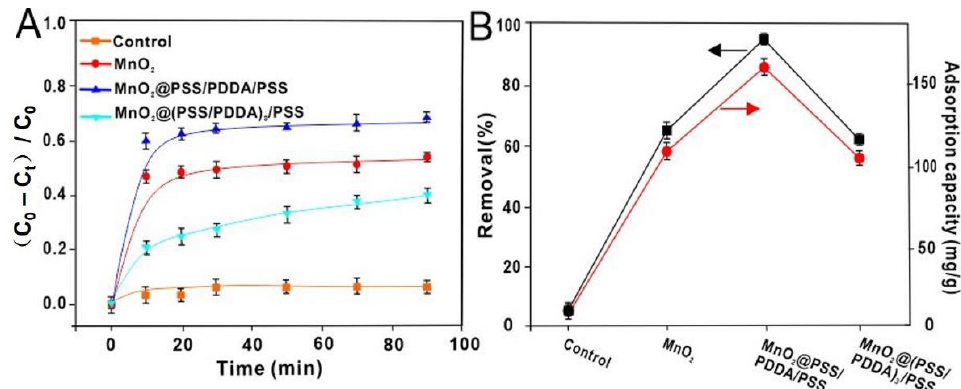
Figure 5. Zn 2+ adsorption on MnO 2 , MnO 2 /PSS/PDDA/PSS, and MnO 2 /(PSS/PDDA) 3 /PSS with an initial concentration of 100 mg/L at 25 °C ( A ), and their corresponding adsorption capacity and removal efficiency ( B ).